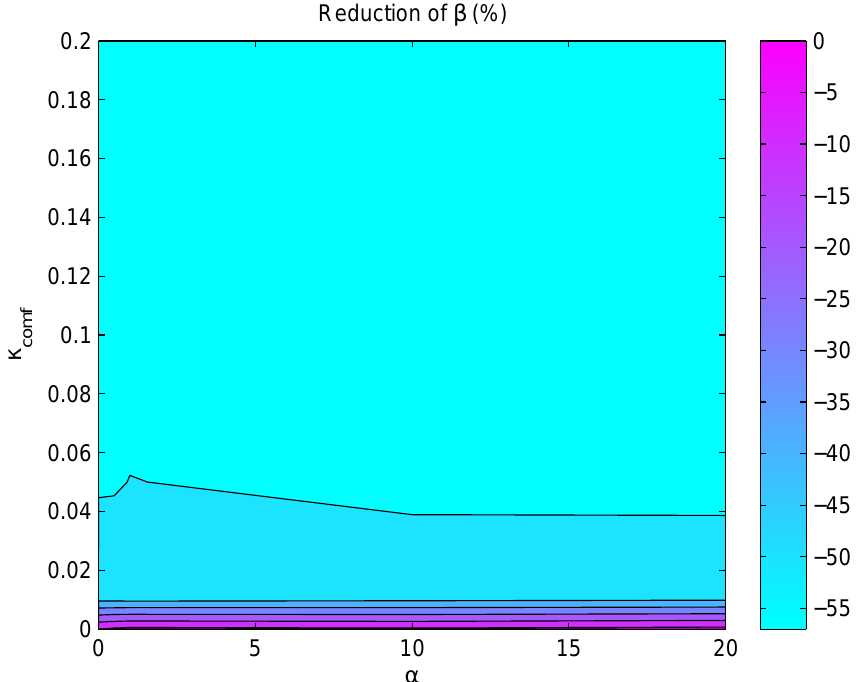
Figure 10. The effect of α and κ value computed for α = κ